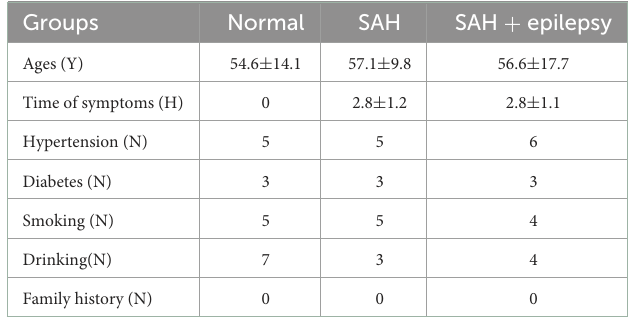
TABLE 1 The clinical characteristics of 21 participants.